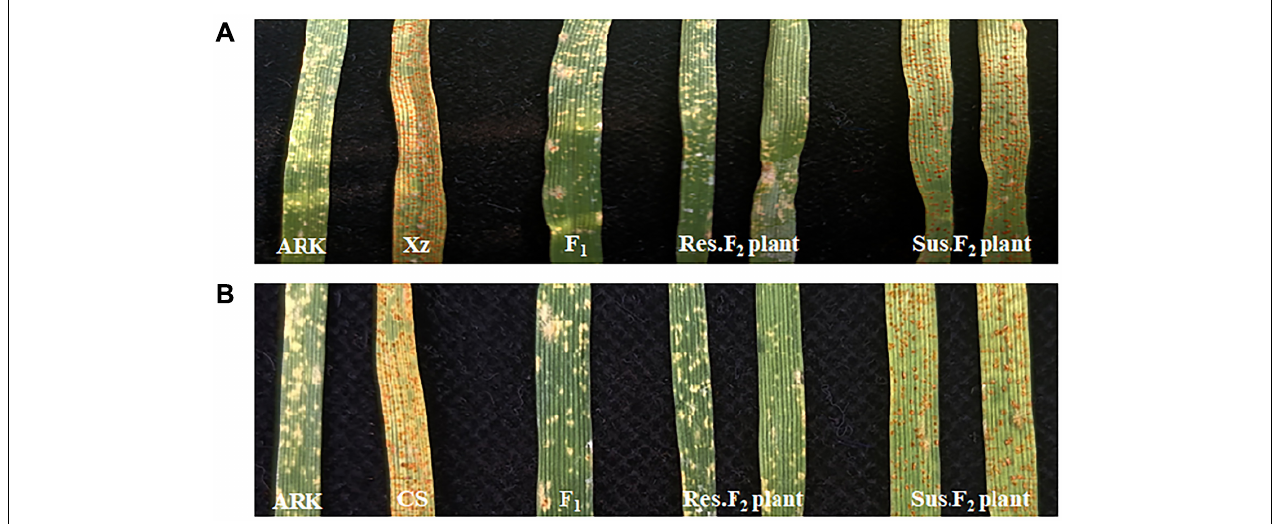
FIGURE 1 | Phenotype of seedling responses after inoculation with Pt race PHT. (A) Altgold (ARK), Xuezao (Xz), F 1 (Xz/Altgold), and typical resistant and susceptible F 2 individuals. (B) Altgold (ARK), CS, F 1 (CS/Altgold) and resistant and susceptible F 2 of individuals.